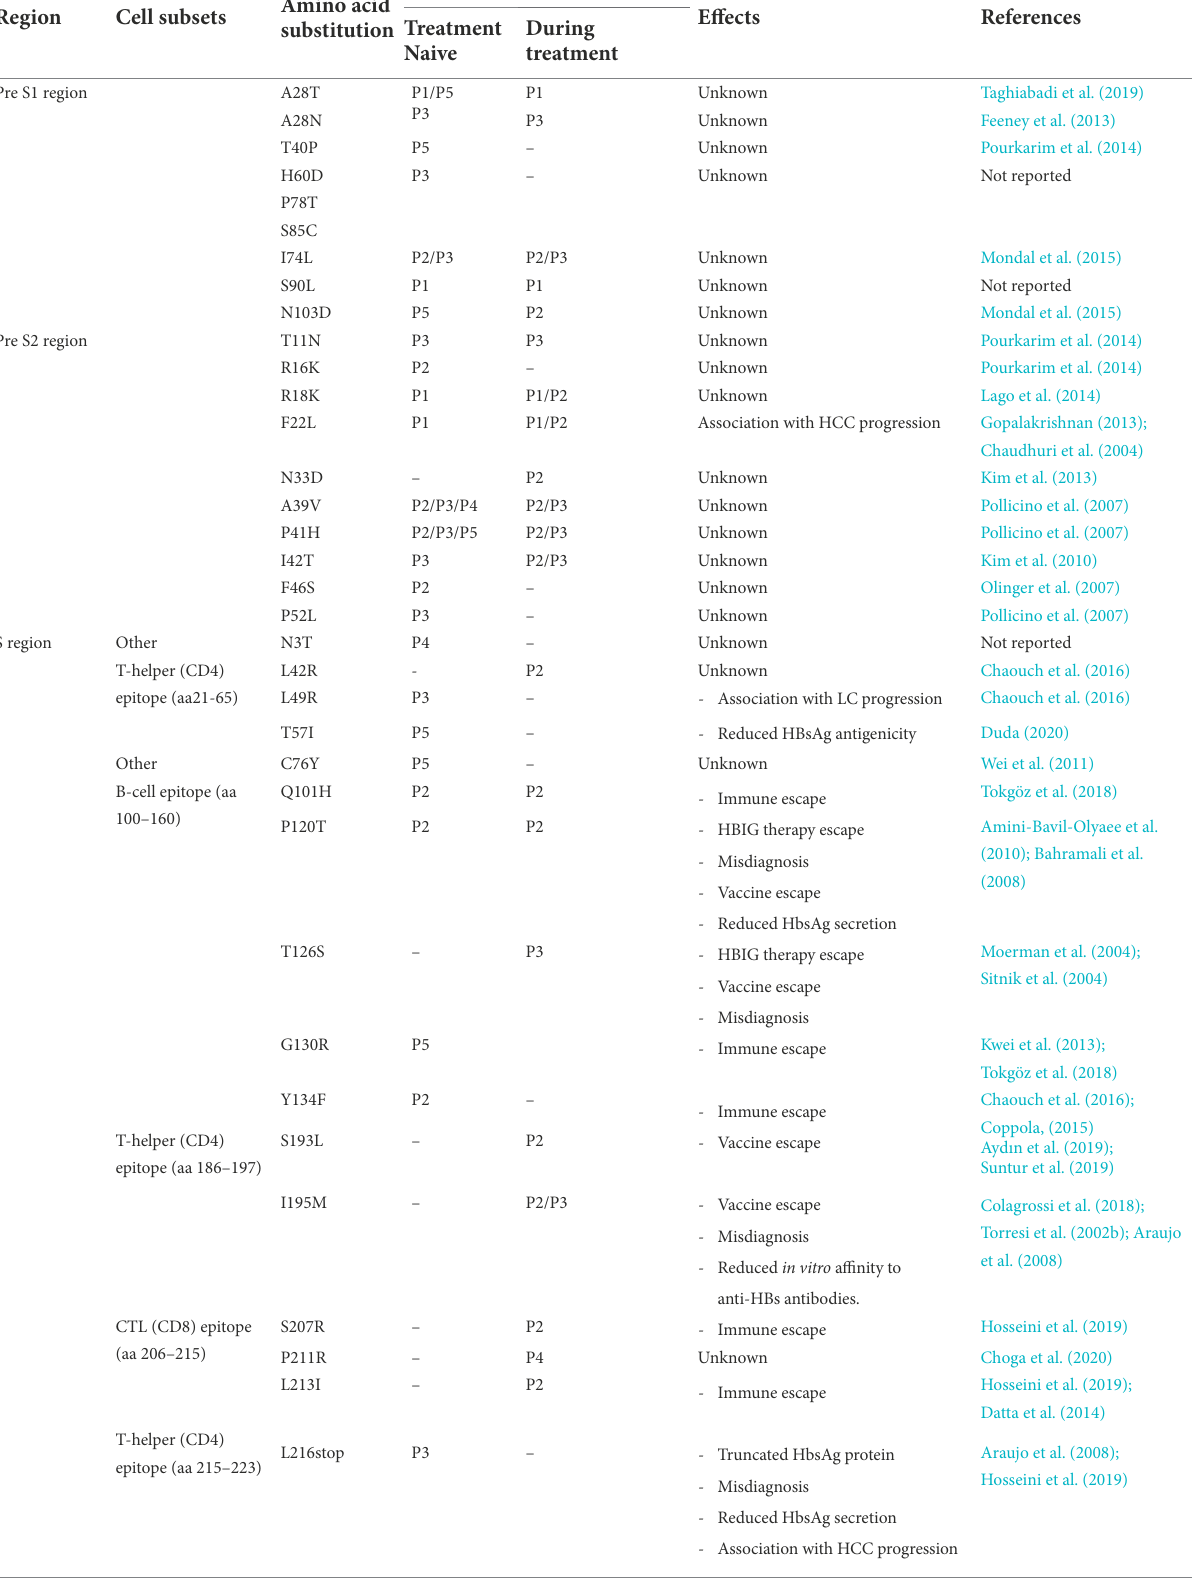
TABLE 3 Amino acid substitutions within the HBV surface gene sequences from the studied patients with their impact.